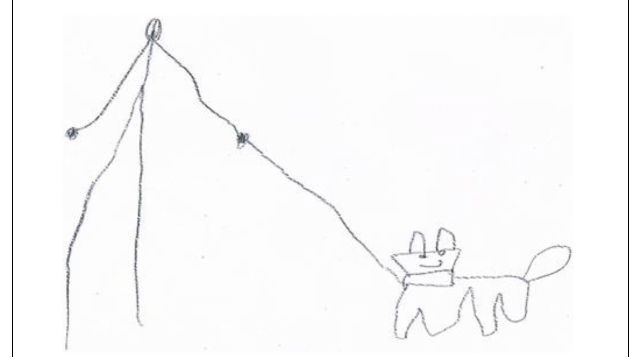
FIGURE 6 | A woman who goes for a walk with her dog—Ja´s, 9 years